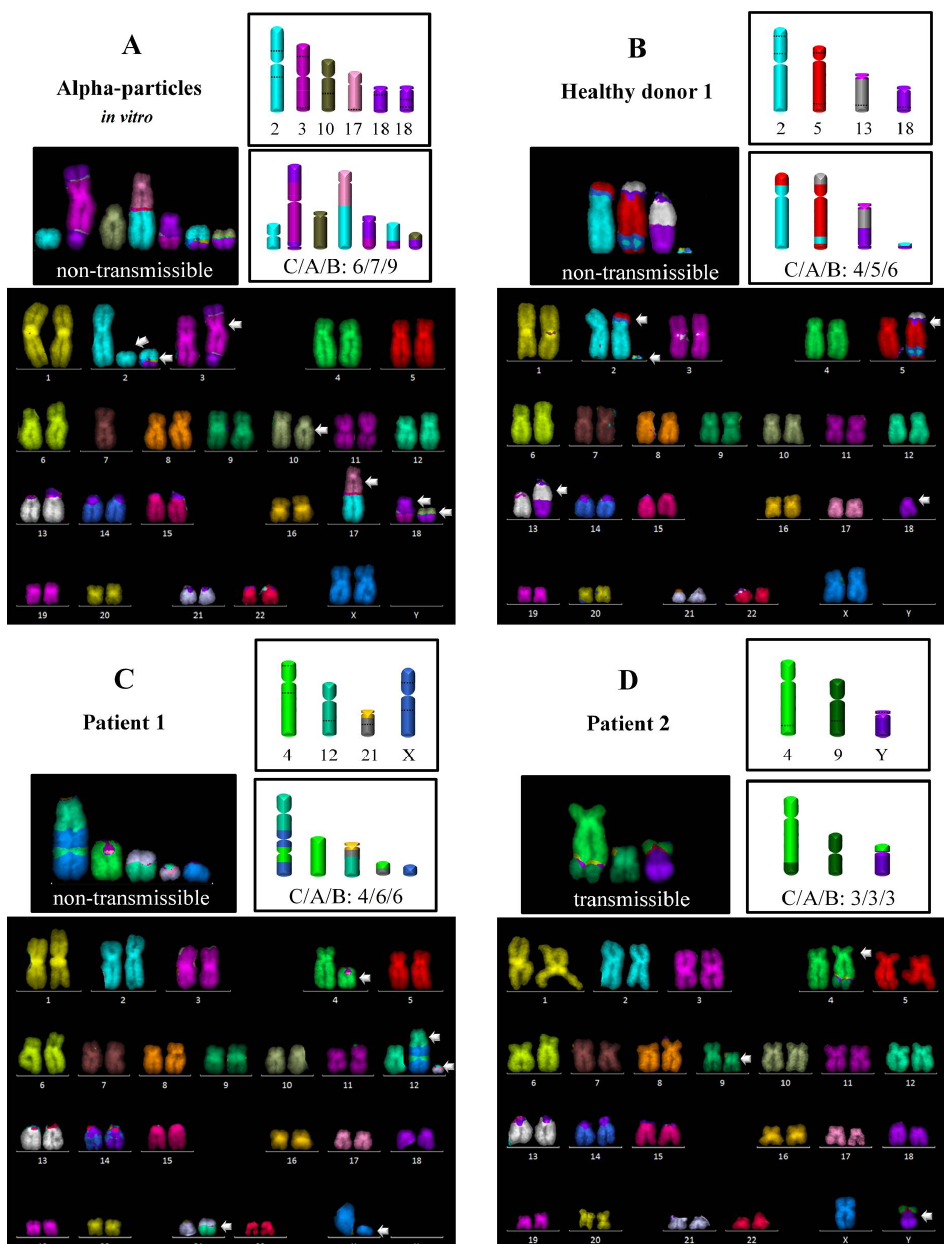
Figure 2. Representative karyotypes with complex aberrations revealed by the mFISH technique together with a schematic description of the breakpoints involved and the resulting rearrangements for cells of ( A ) healthy donor 1 exposed in vitro to 0.25 Gy alpha particles, ( B ) healthy donor 1 (control cells), ( C ) patient 1 (before therapy) and ( D ) patient 2 (six weeks after the onset of therapy). Additionally, the level of complexity is given according to the CAB system (number of chromosomes, chromosome arms and breaks involved). Arrows indicate the chromosomes involved in the respective complex